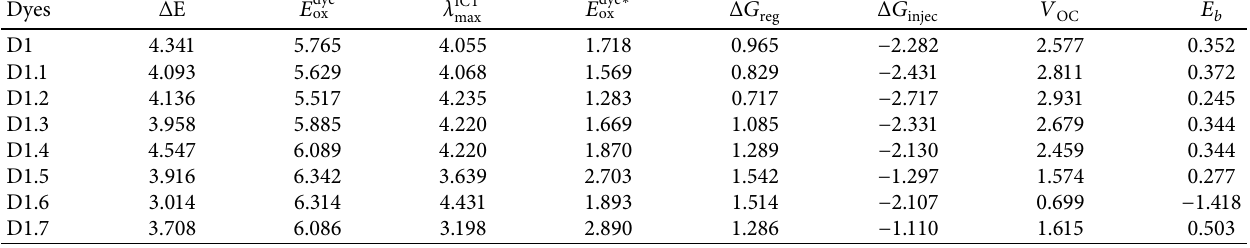
ICT ), driving max